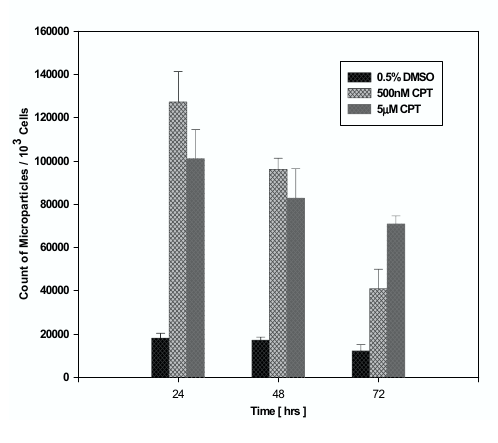
Figure 4 Release of annexin V-binding membrane microparti- cles in subconfluent, confluent and overgrown HUVEC culture treated with camptothecin HUVEC at 24 hrs (50% of confluence), 48 hrs (reaching confluence) or 72 hrs (overgrown) in culture were incubated for 24 hrs with 0.5 % DMSO, 500 nM or 5 µ M CPT in medium. After incuba- tion supernatant from cell culture was harvested and annexin V-FITC-binding MP were counted. Means of 4 experiments ± SD are presented, significant differences (p < 0.05,